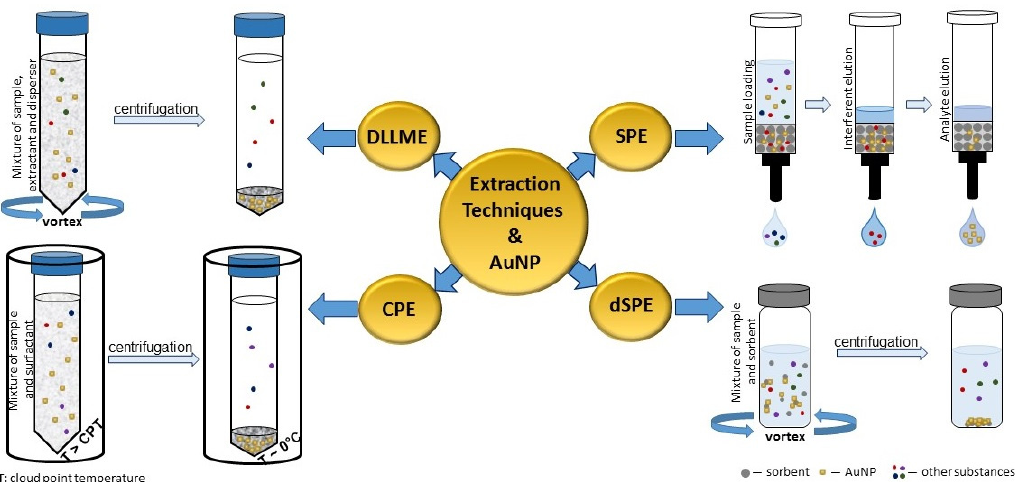
Figure 1. A schematic illustration of four extraction procedures recommended for separation and preconcentration of AuNP.